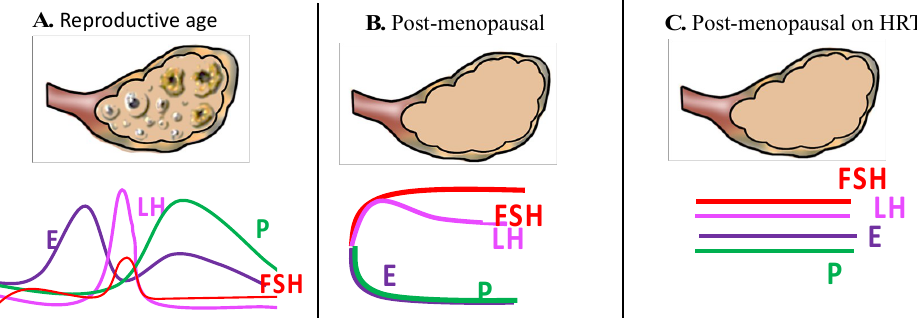
Figure 1. Schematic representation of the level of various ovarian hormones in reproductive age, post-menopausal and in women on HRT.